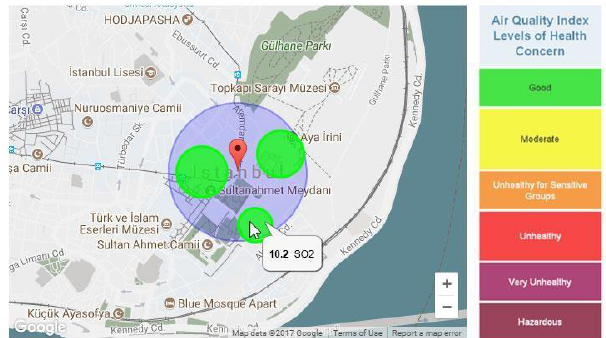
Figure 7.Visualisation of Air Quality